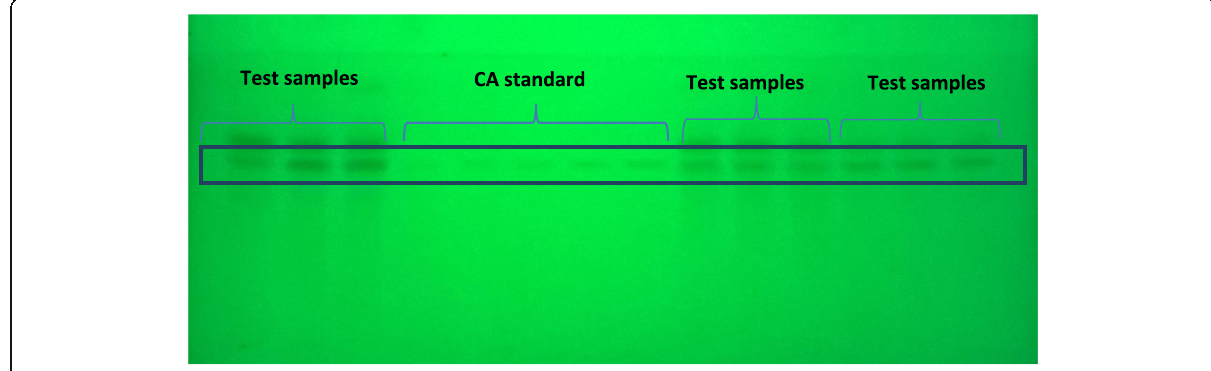
Fig. 2 HPTLC profiles of test samples and caffeic acid